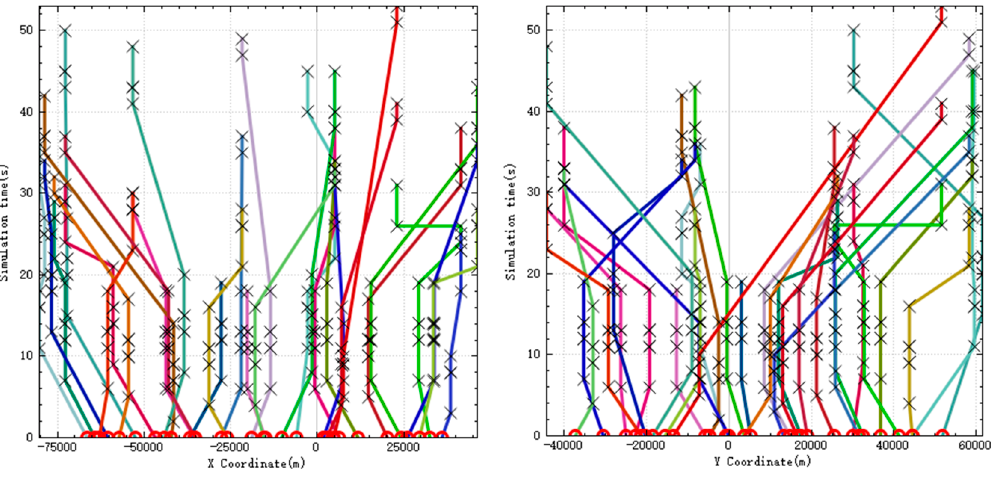
Figure 5. UAV position over time.